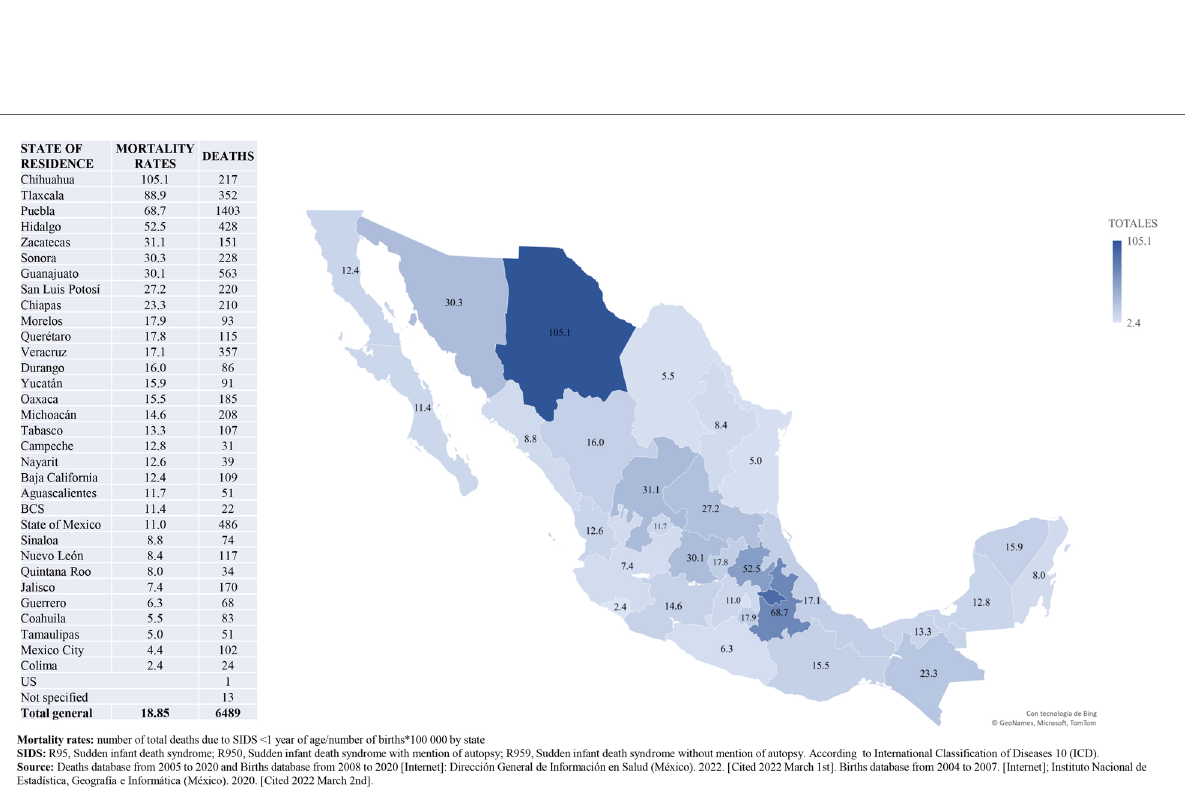
FIGURE 4 Mortality rates (deaths/100,000 live births) due to SIDS. State of residence, Mexico. 2005 – 2020